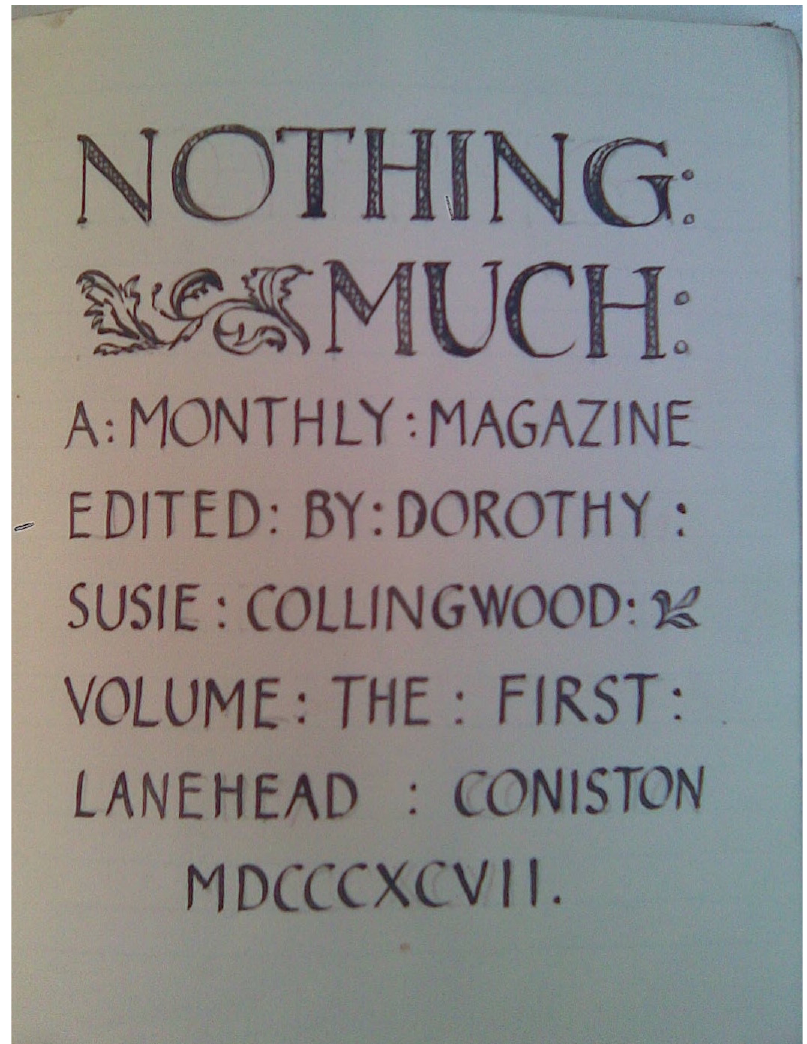
Figure 4. Nothing Much (1897) (Courtesy of Abbot Hall,